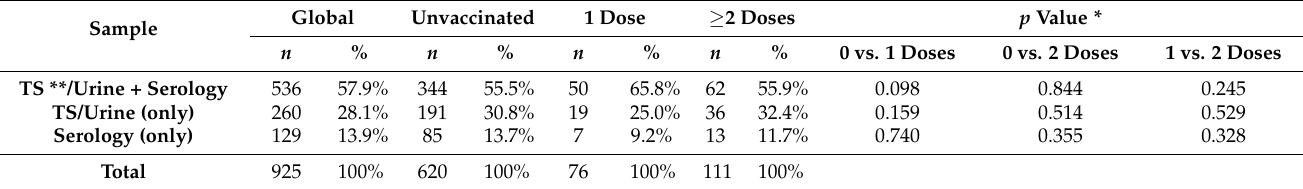
Table 5. Laboratory study of laboratory-confirmed measles cases. Spain, 2014–2020. Sample